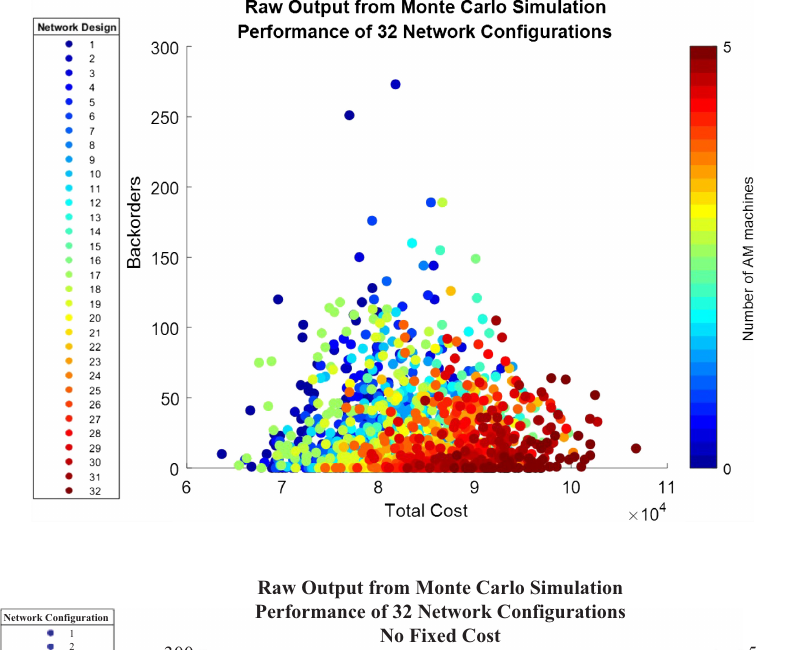
Figure 6. (Color online) Monte Carlo simulation raw outputresults withAM fixed costs removed. Data points are grouped by each of the 32 network